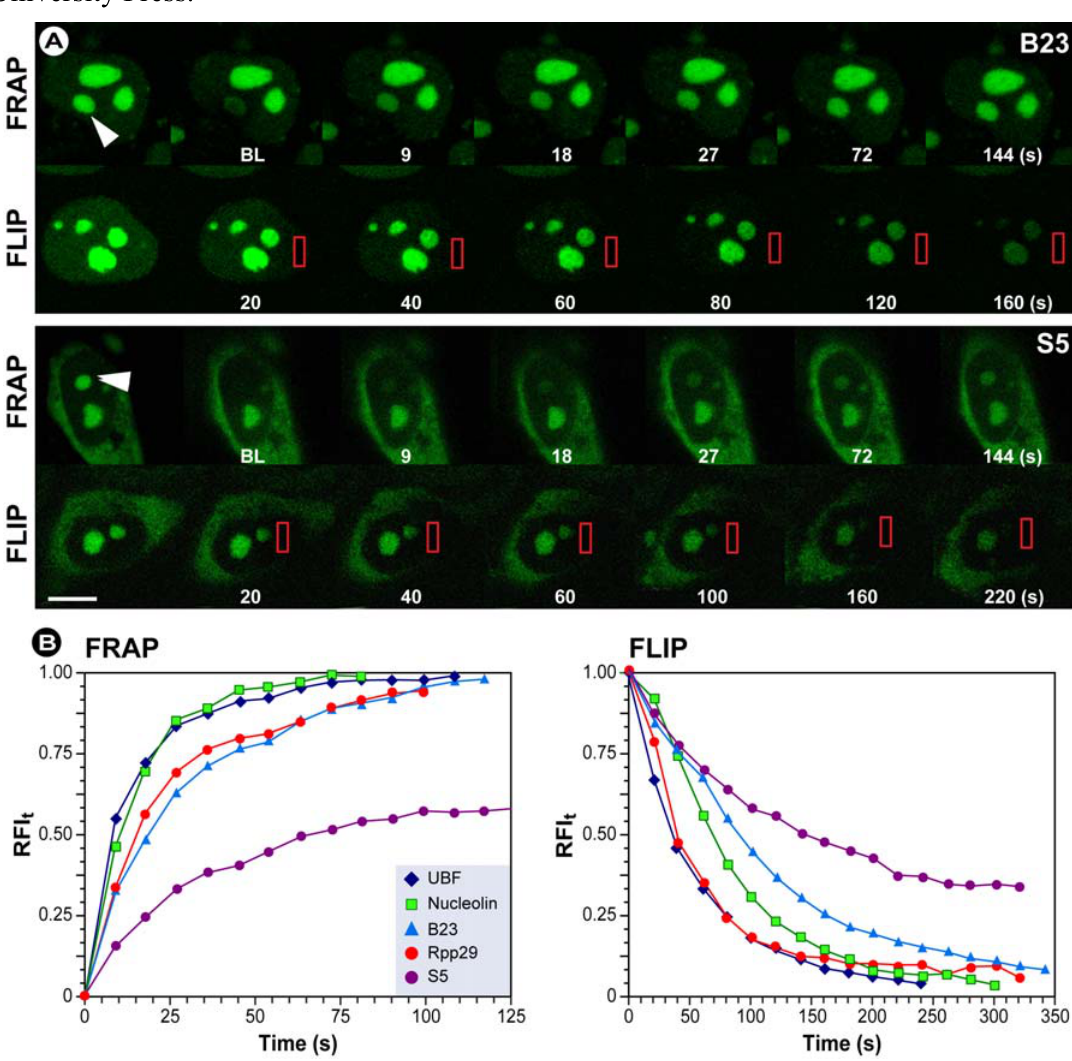
Figure 16. Combined FRAP and FLIP experiments assess the difference in mobility of nucleolar and ribosomal proteins in transit between the nucleolus and nucleoplasm. ( A ) In the FRAP panel the arrows indicate the sites of bleaching (ROI). In the FLIP panels the red rectangles indicate the area to be bleached. BL is the first image obtained immediately after photobleaching. Bar, 10 μ m. ( B ) The FRAP and FLIP analysis plots show that the GFP- labeled ribosomal protein (S5) exits the nucleolus slower than the nucleolar factors B23, UBF, Nucleolin and Rpp29. Adapted from [132] with permission. © 2001 Rockefeller University